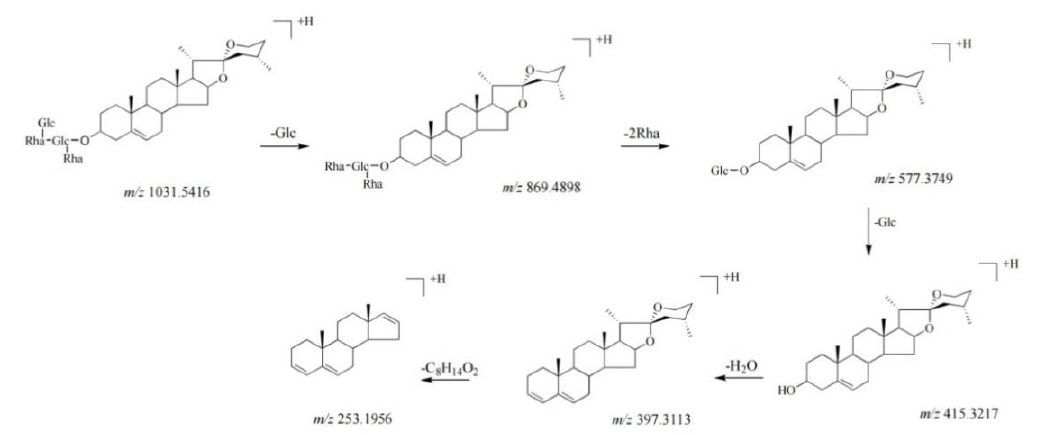
Figure 3. The fragmentation pathways of compound 44 in positive ion mode [21,25,26].